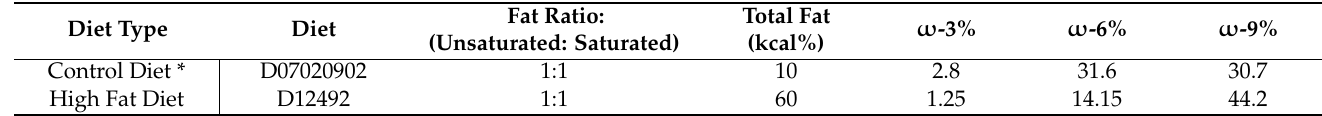
Table 1. The experimental murine diet (D12492) and the estimated contribution of the essential ω -3, ω -6, and ω -6 fatty acids within the diet. The HFD diet was composed of 9.3% PUFA (soybean) and 91.7% of a monounsaturated and saturated mix. * The control diet was not investigated in this study and is included for reference purposes only.